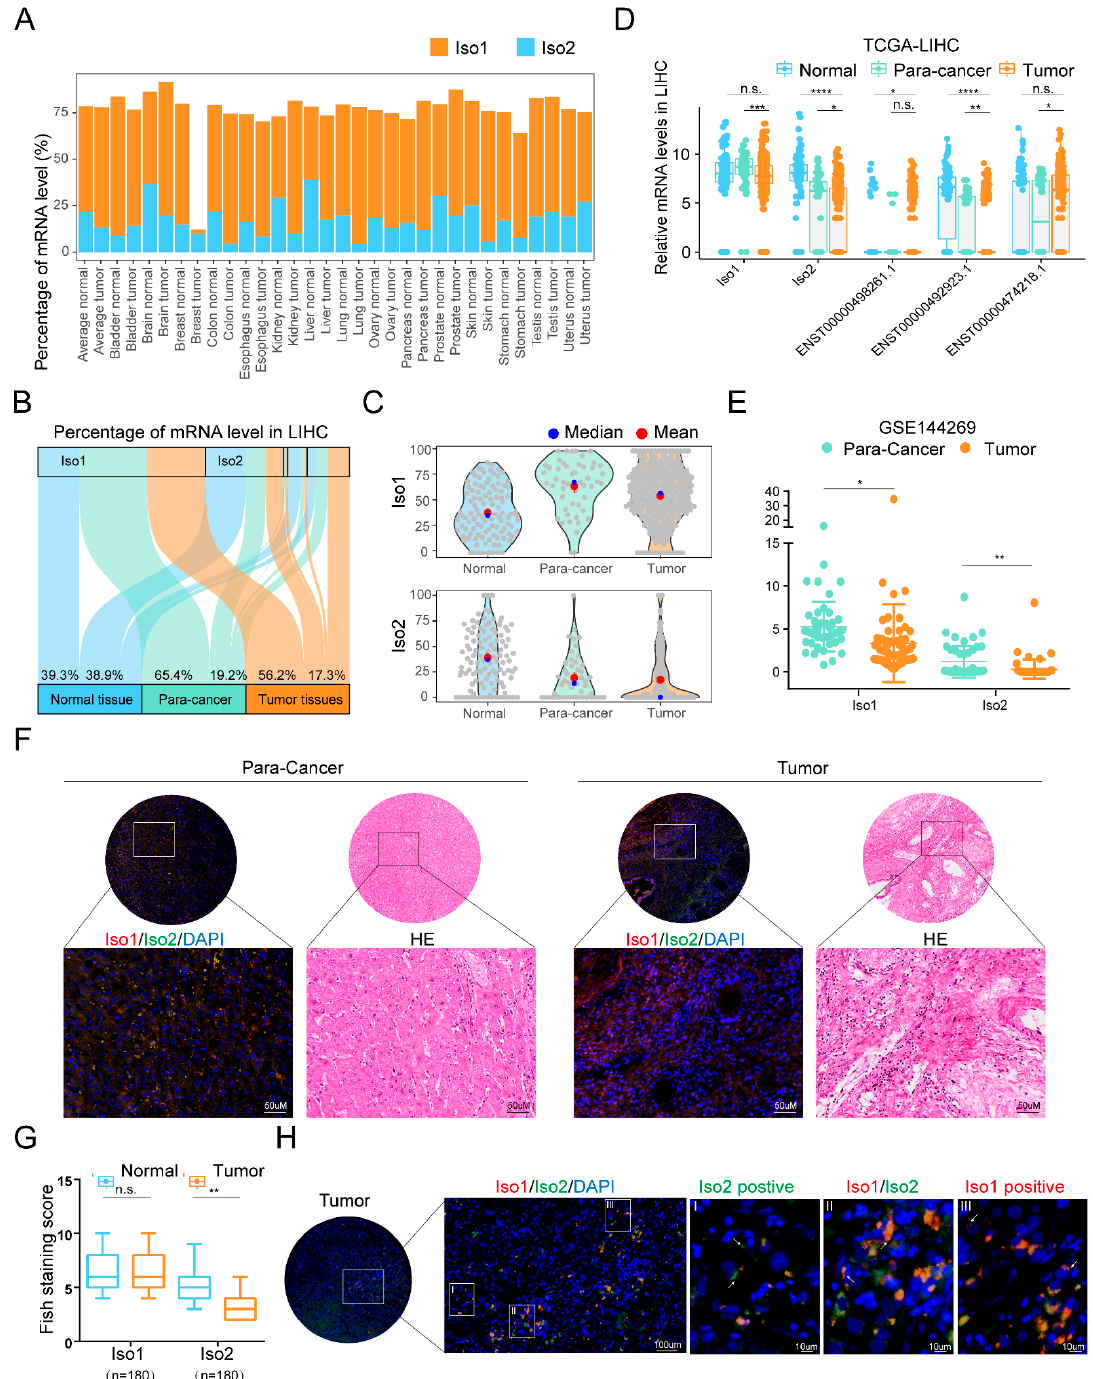
Figure 1. Different expression patterns of two mPD-L1 in liver cancer. ( A ) Analysis of the transcriptional isoform percentages of PD-L1 gene in patients across 16 tissue types in TCGA and GTEx data. ( B , C ) Isoform percentages of PD-L1 in normal, para-cancer and tumor tissues of liver cancer. ( D , E ) Relative mRNA levels of PD-L1 transcripts in the TCGA-LIHC and the Mongolian liver cancer cohorts (GSE144269). ( F , G ) Representative images and statistical analysis on the FISH intensity of Iso1 and Iso2 in a liver cancer tissue microarray. HE staining images were used to determine the location of Iso1 and/or Iso2-positive cells. Statistical data were presented as mean ± SD, n.s.: not significant, * p < 0.05, ** p < 0.01, *** p < 0.001, **** p < 0.0001. ( H ) Iso1 and/or Iso2-positive cells in another representative tumor